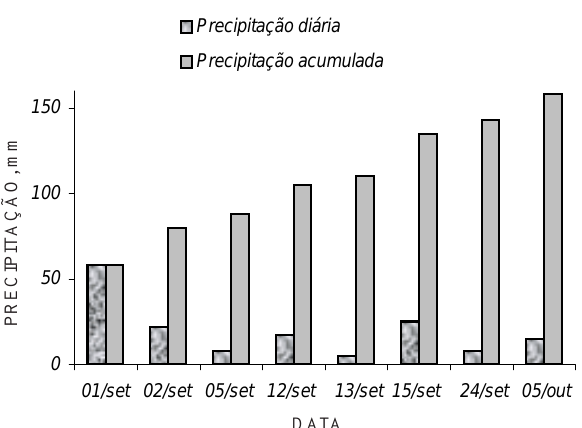
Figura 4. Precipitação ocorrida no período em que a volatilização foi